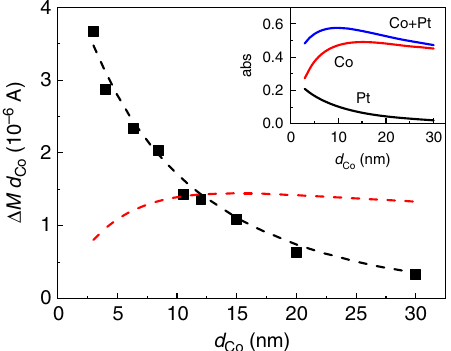
Fig. 3 Comparison with light absorption. a The amount of measured optical spin – orbit torque in the sap/Co( d Co )/Pt(2) structure (black squares). Dashed lines are fi ttings with light absorption in Pt (black line) and in Co (red line). For the fi tting, we use a quantum ef fi ciency ( η ) of 0.045 and 0.008 in Eq. (1) for black and red lines, respectively. Inset shows the calculation of light absorption (abs) of Pt (black line), Co (red line), and Co + Pt (blue line) in the sap/Co( d Co )/Pt(2) structure (light is incident on the sapphire substrate side). The calculation is done with refractive indexes of each layer and initial light energy of